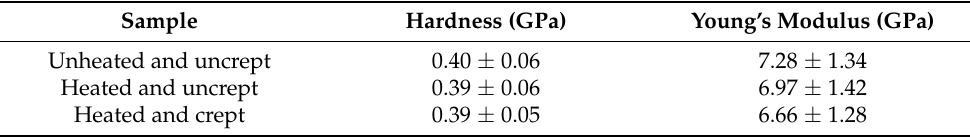
Figure 10. The nanoindentation ( a ) hardness and ( b ) Young’s modulus for the unheated and uncrept, heated and uncrept, and heated and creeped samples indented to a maximum displacement of ~1000 nm. Table 2. The hardness and Young’s moduli of the unheated and uncrept, heated and uncrept, and heated and creeped specimens at a maximum displacement of ~1000 nm.